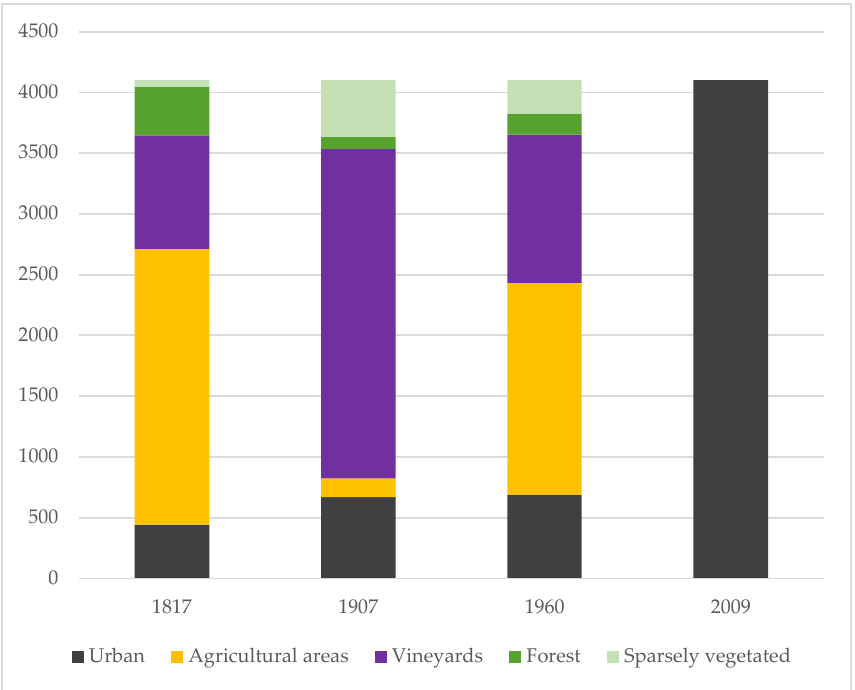
Figure 8. Land use class areas inside the 2009 urban areas on 1817–1907–1960 LU maps. The comparison of the LU map of 2009 with the 1817 one shows that urban expansion has principally affected agricultural areas (72% of which have disappeared, including vineyards in this class), but also a significant amount (10%) of forests have been lost. The comparison of the LU map of 2009 with the 1907 and 1960 ones shows a similar result,